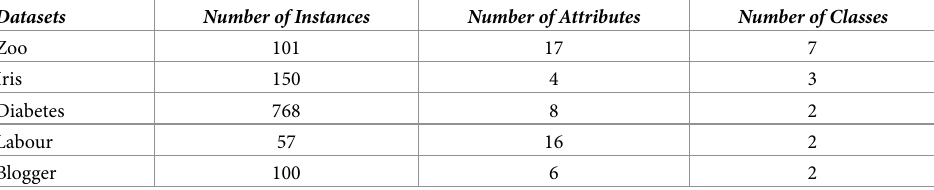
Table 2. Datasets description.